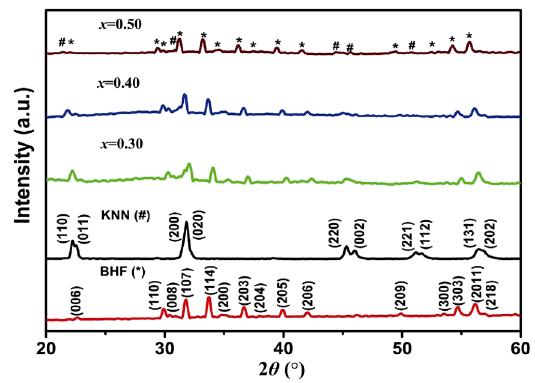
Fig. 1 XRD patterns of (1 ̶ x )KNN–( x )BHF ( x = 30, 40, and 50 wt%) composites along with pure KNN and BHF phases where # represents KNN and * represents the BHF